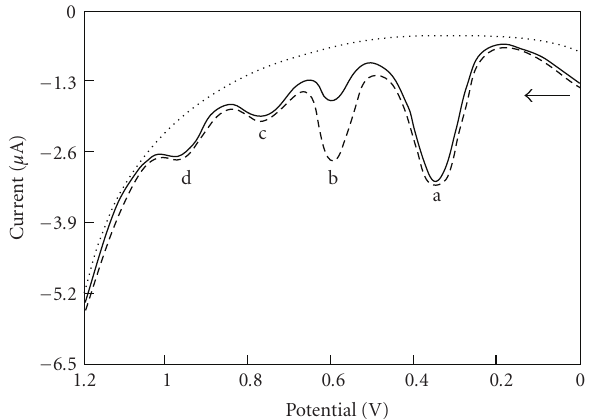
Figure 6: Square wave voltammograms for urine sample of asthma patient (—) and urine sample of patient spiked with salbutamol (---) using SWNT/EPPGE. The background PBS at modified electrode is shown as ( ... ).